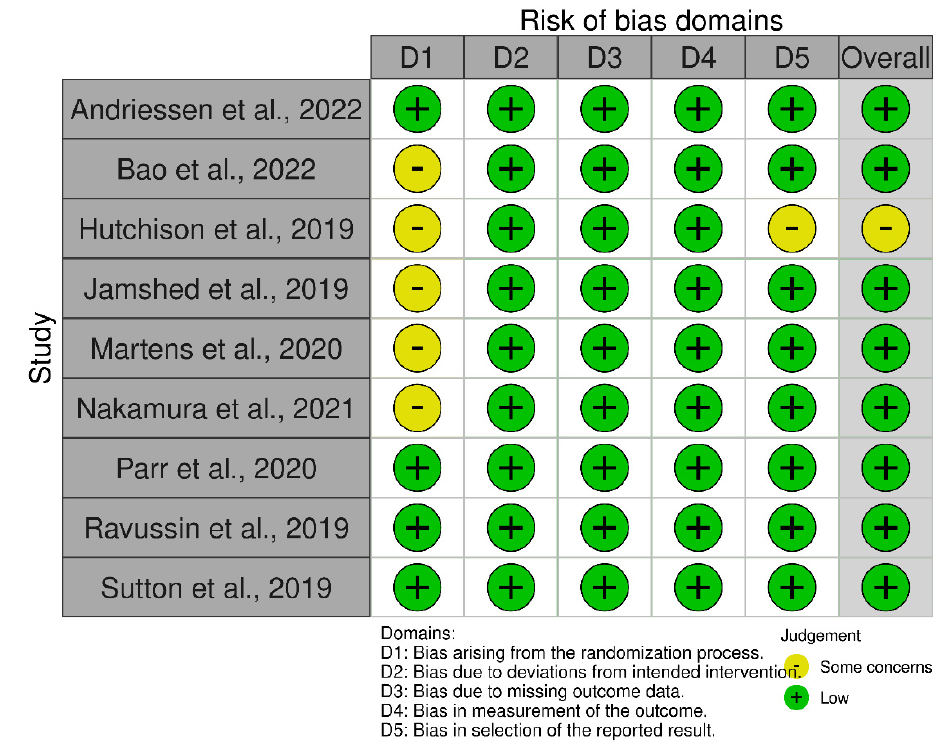
Figure 4. Domains of Risk of Bias (Randomized Controlled Crossover Studies) [7,54–61].